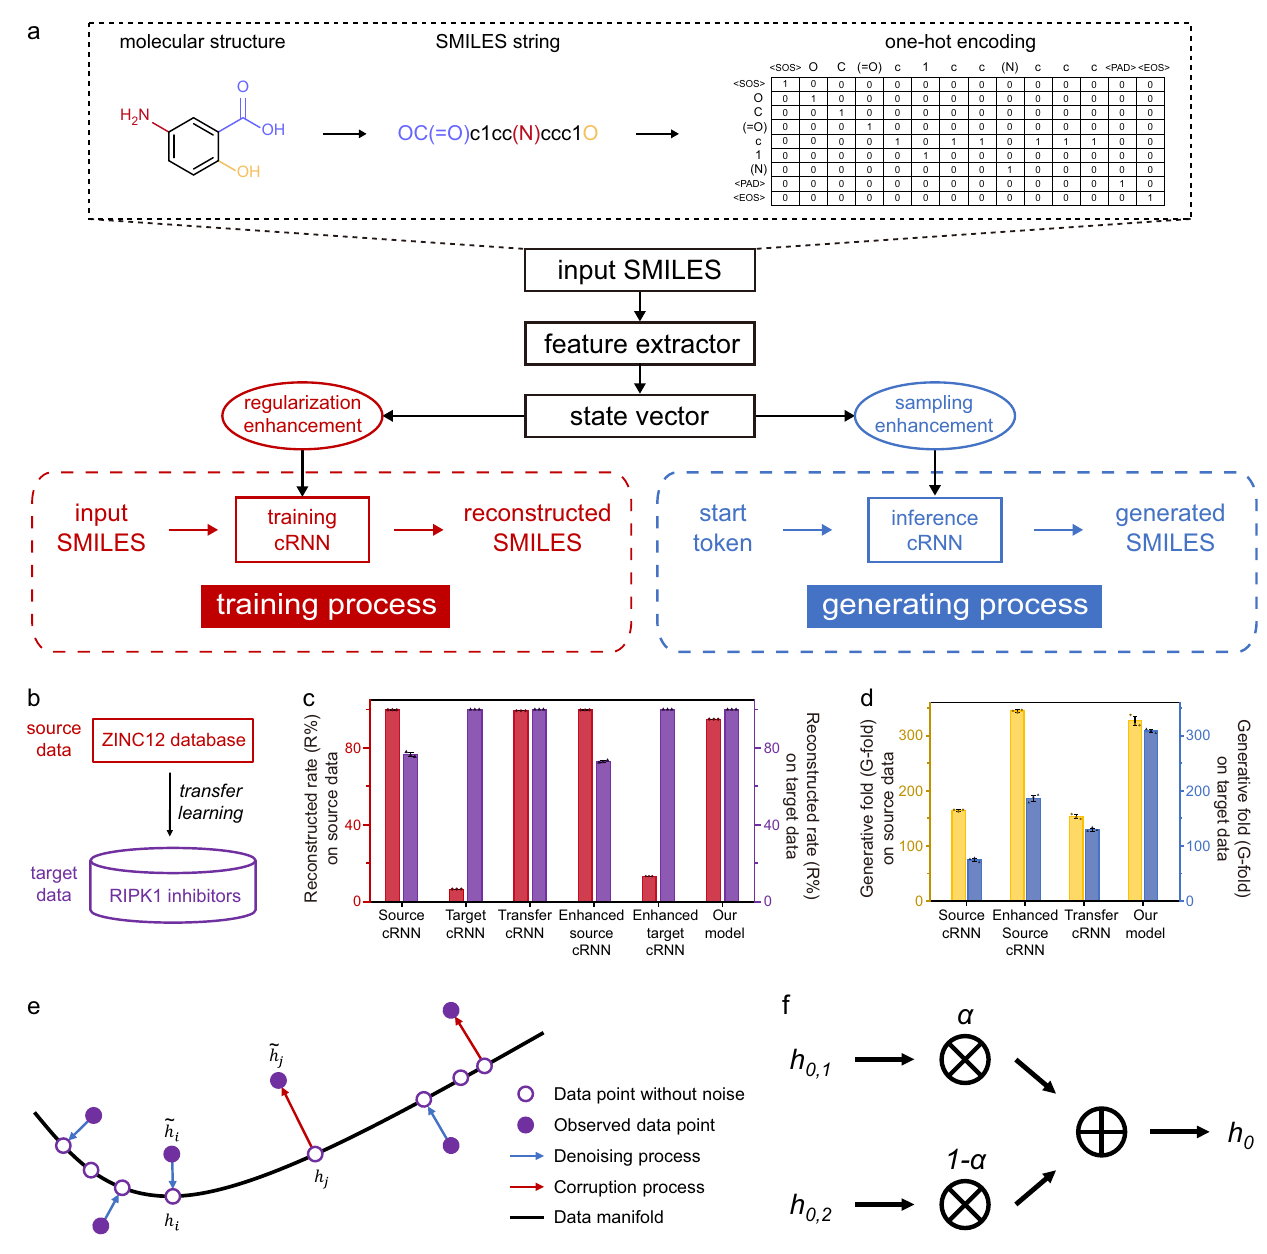
Fig. 2 | Establishment and performance of the cRNN-based generative model. a The diagram of cRNN-based generative model. b Schematic of transfer learning. Molecules from the ZINC12 database (~16 million molecules) and known RIPK1 inhibitors (1030 molecules) are used as the source data and the target data, respectively. c , d The reconstruction performance ( c ) and the generation perfor- mance ( d ) of different models ( n =3). All results are shown as mean±standard deviation. Source cRNN: training on the source data; target cRNN: training on the target data; transfer cRNN: training with transfer learning on the source and the target data; enhanced source cRNN: training with regularization enhancement on the source data; enhanced target cRNN: training with regularization enhancement and autoencoder 21 . The architecture of the proposed GDL model is schematically shown in Fig. 2a. Molecules are represented by SMILES strings 20 ,whichareencodedbythe “ one-hot ” representationforinputs and outputs. Combined with the state vectors given by the feature extractor as the conditional input, the cRNN model is trained to gen- erate molecules following the same chemical distribution of given training data in an unsupervised-learning manner. In the training